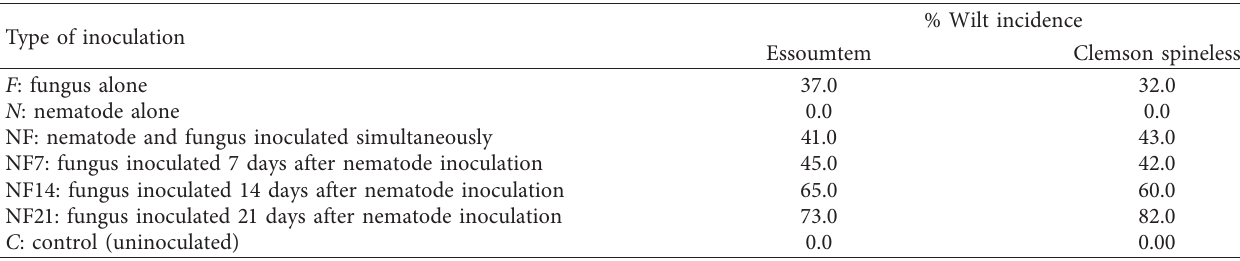
Table 4: Percentage wilt incidence for “Essoumtem” and “Clemson spineless” under various inoculations in pot experiment. Type of inoculation